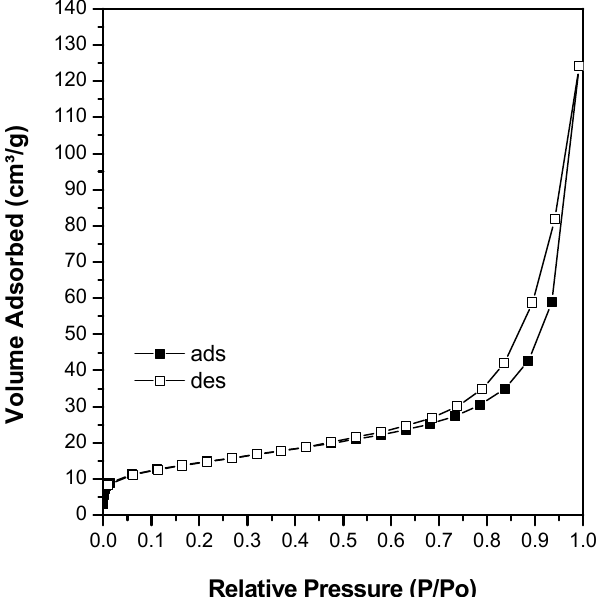
Figure 3. Isotherm of N 2 adsorption-desorption of sodalite without hexadecyltrimethylammonium bromide (CTABr) addition.